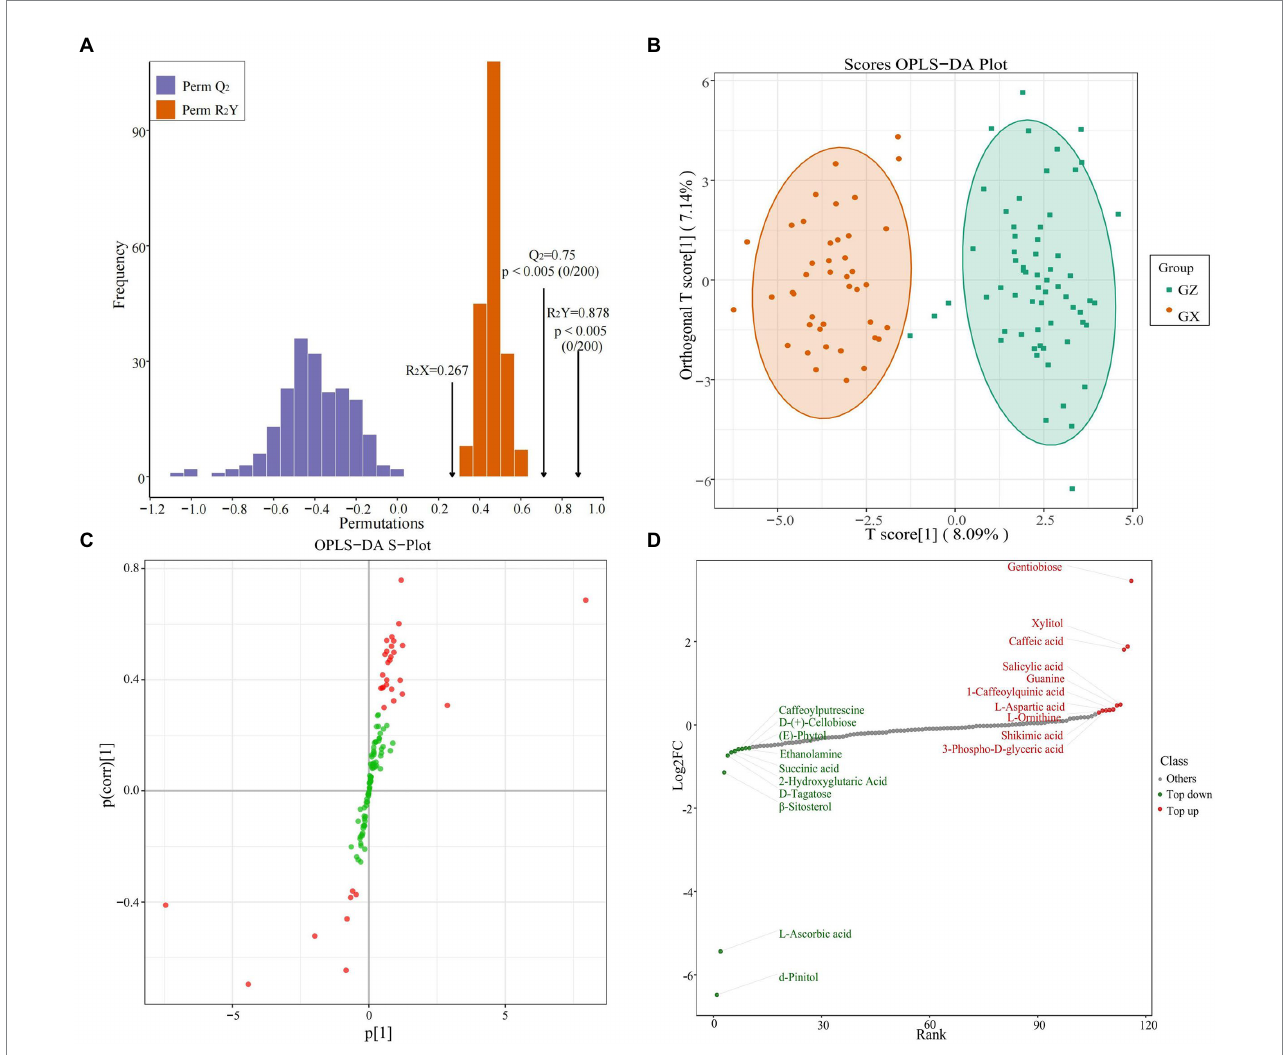
FIGURE 5 Validation of OPLS-DA model (A) , scores OPLS-DA (B) , s-plot of OPLS-DA (C) , and top 10 upregulated and downregulated metabolites of GZ vs. GX provinces (D)